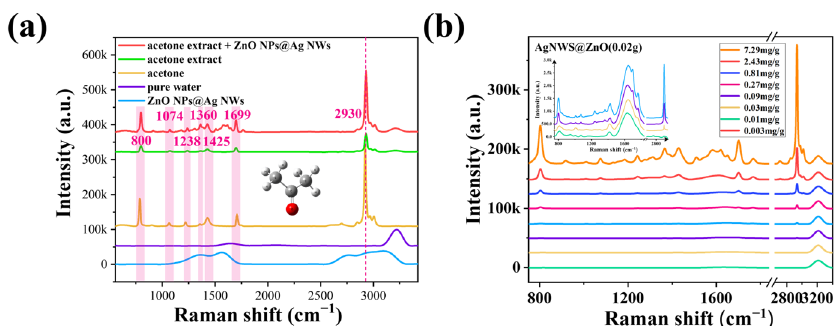
Figure 7. ( a ) Raman spectra of ZnO NPs@Ag NWs substrates, pure water, acetone, acetone extract (extractant was pure water), and acetone extract enhanced by ZnO NPs@Ag NWs. ( b ) SERS spectra of different acetone extract concentrations (the inset shows the local magnifications of 0.09, 0.03, 0.01, and 0.003 mg/g).